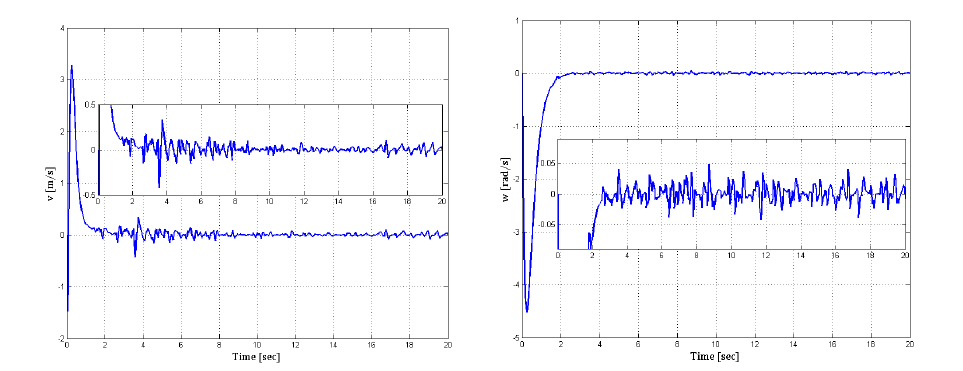
Figure 10. Posture stabilization with White Noise (parallel parking with initial heading angle at 180 ◦ ): linear velocity v (m/s) and angular velocity ω